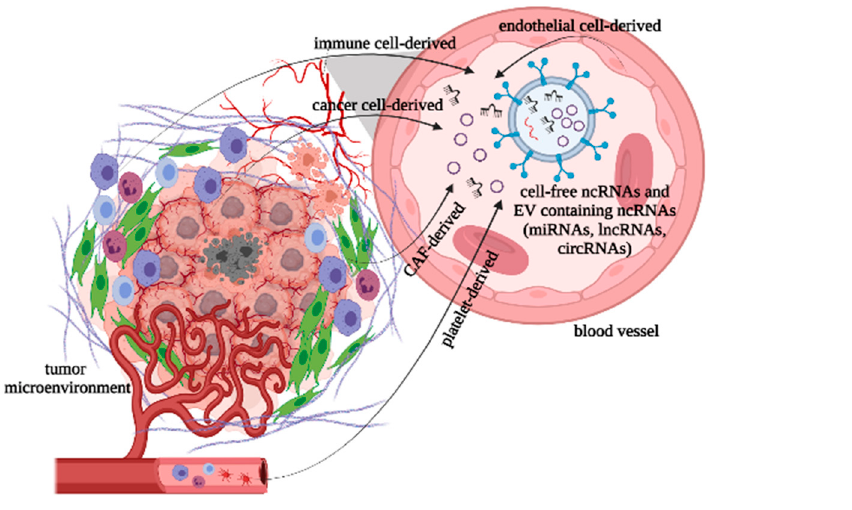
Figure 7. Possible sources of circRNAs in malignancy, based on the limited number of existing studies. Created in